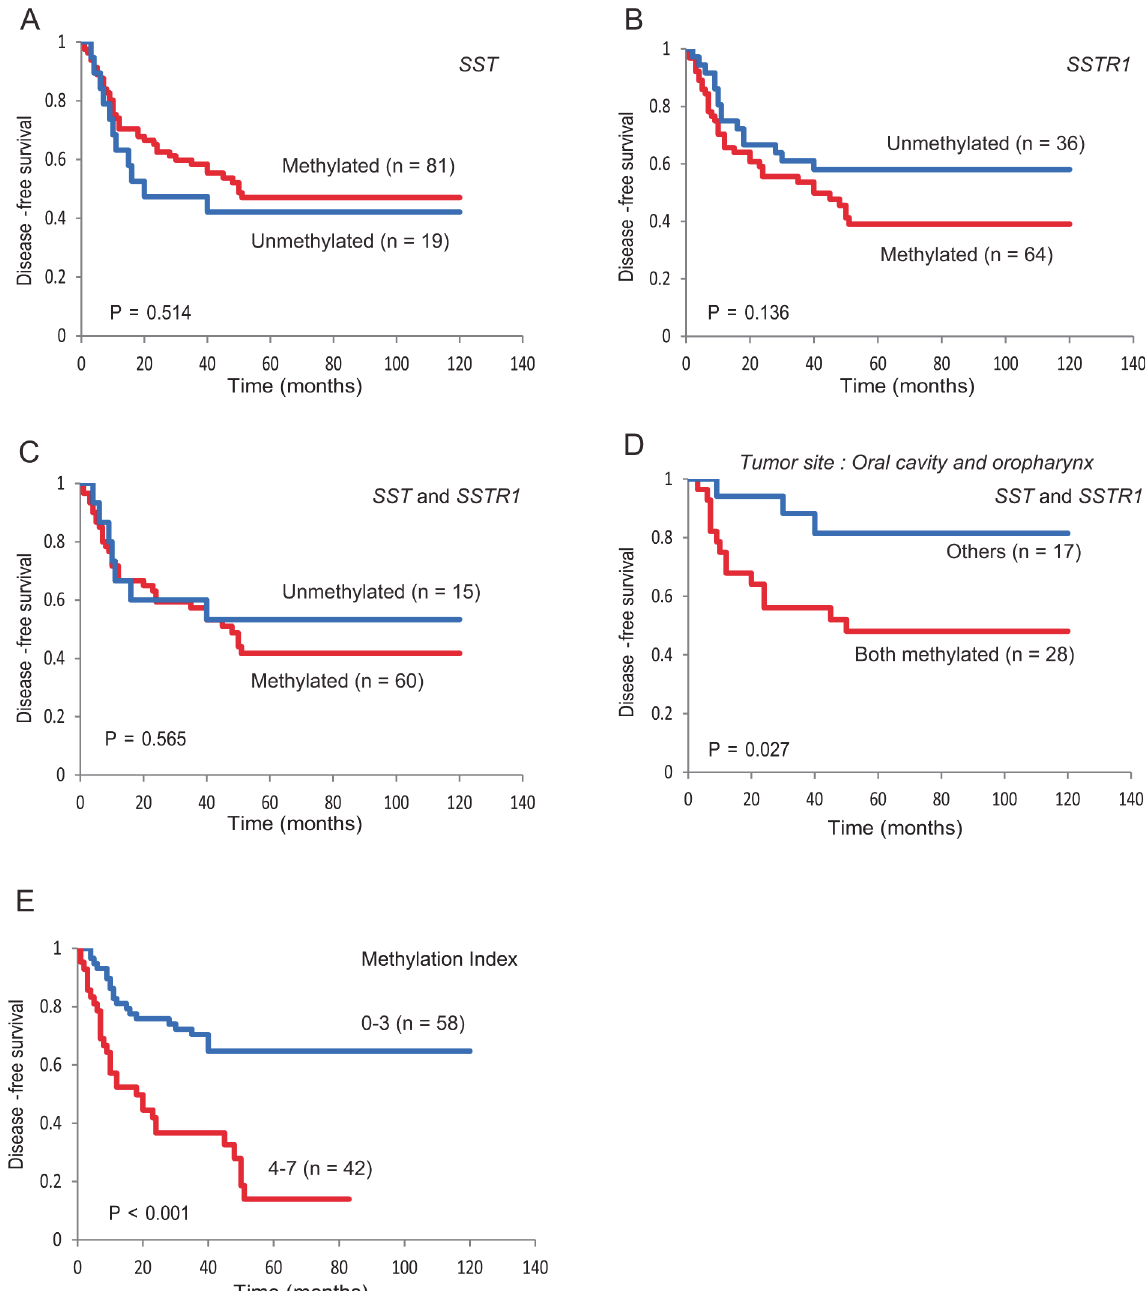
Fig 4. Kaplan-Meier survival curves for patients with HNSCC. Disease-free survival by (A) SST methylation status, (B) SSTR1 methylation status, (C) SST and SSTR1 methylation status, (D) SST and SSTR1 methylation status in oral cavity and oropharynx patients, and (E) number of MI. Disease-free survival was briefer in patients with MI (4 – 7) than in those with MI (0 – 3) methylation ( P < 0.001, Log-rank test). Blue line, patients without methylation; red line, patients with